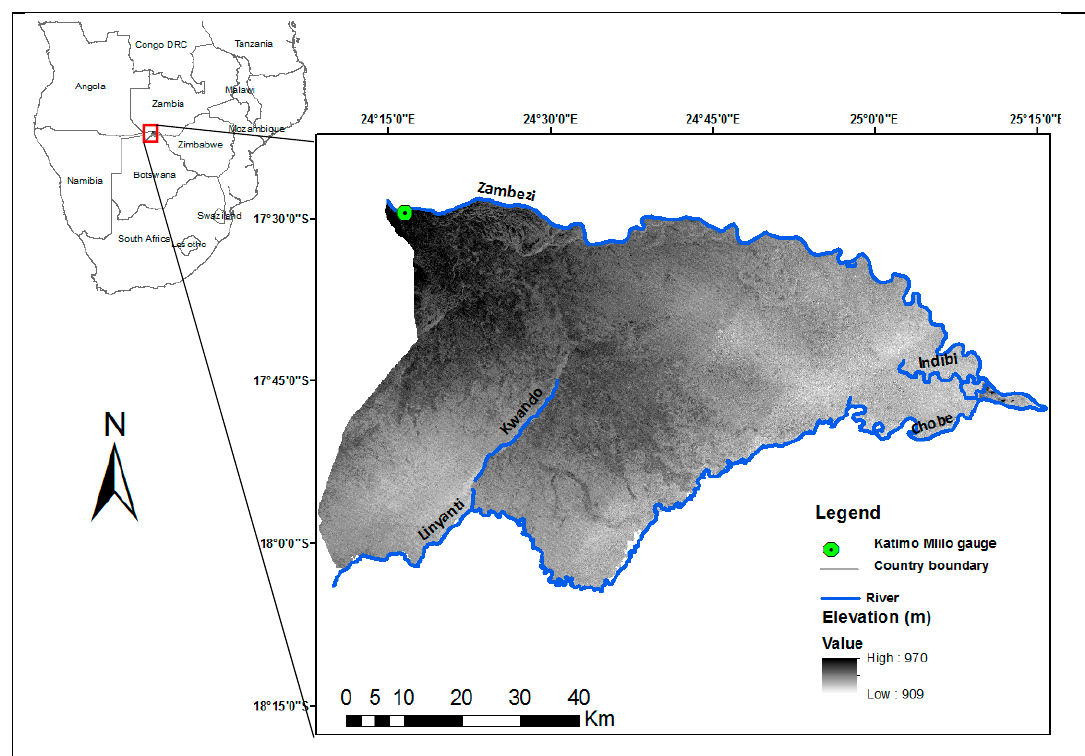
Figure 1. Location of the study area.